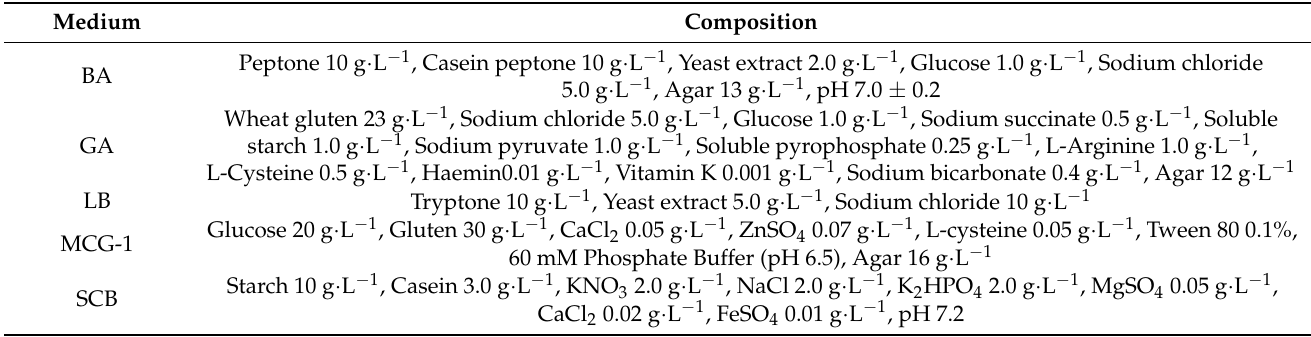
Table 1. The compositions of five culture